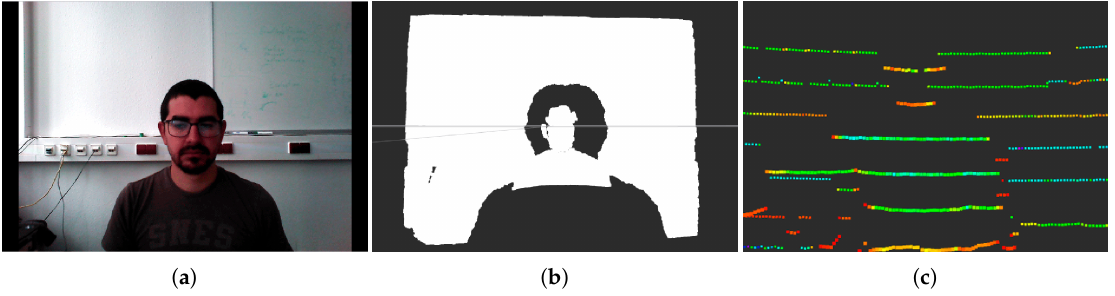
Figure 1. Illustrative example of sensed data by an RGB-D camera and a 3D LiDAR: ( a ) RGB-D camera color image; ( b ) point-cloud provided by an RGB-D camera; ( c ) point-cloud provided by a